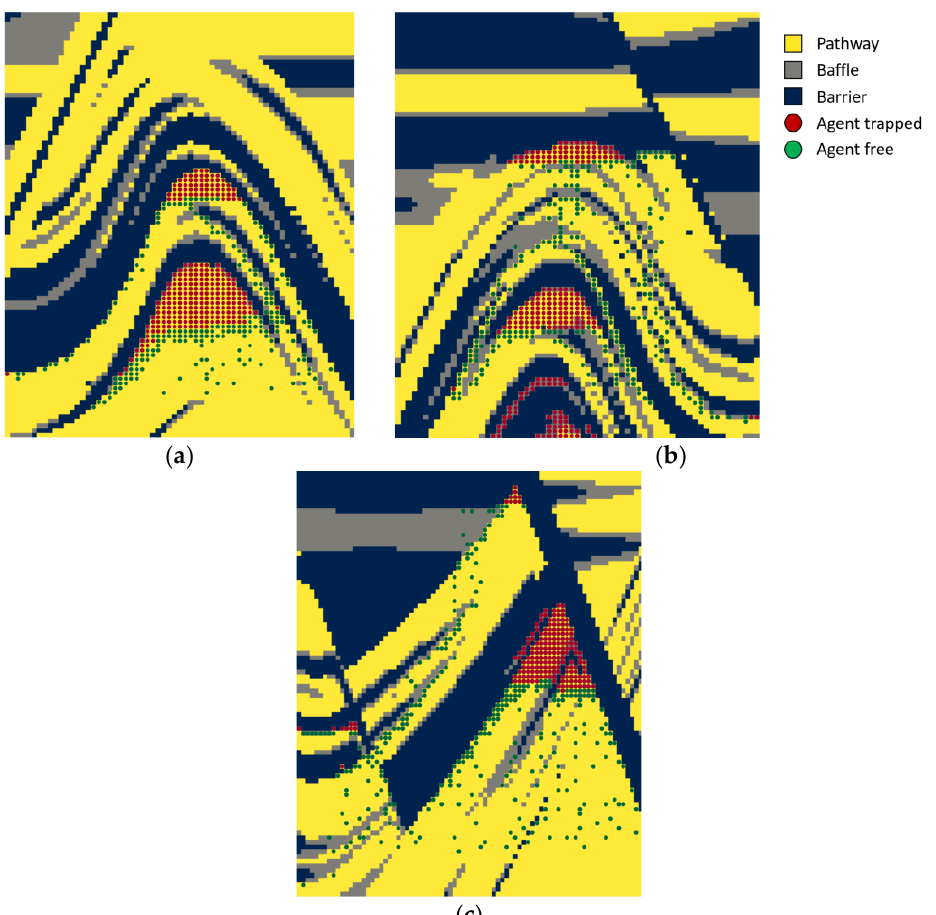
Figure 5. ( a ) Anticline scenario with barrier layer completely sealing the structure; ( b ) anticline scenario leaking on the right side of the structure; ( c ) fault block scenario with an impermeable fault on the top left side of the environment. For each scenario, the agents are initialised from the bottom layer of the environment.